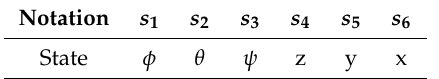
Table 1. State vector of the quadrotor helicopter